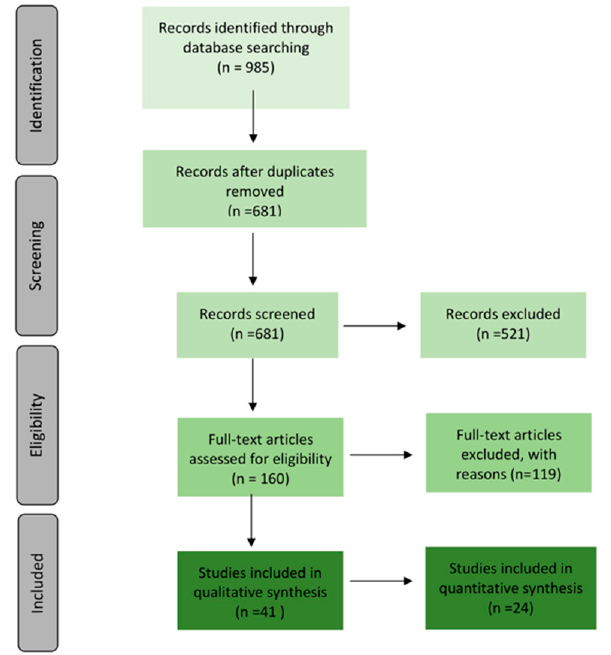
Figure 1. Prisma Flow Chart. The selection process of the studies included in the present system- atic